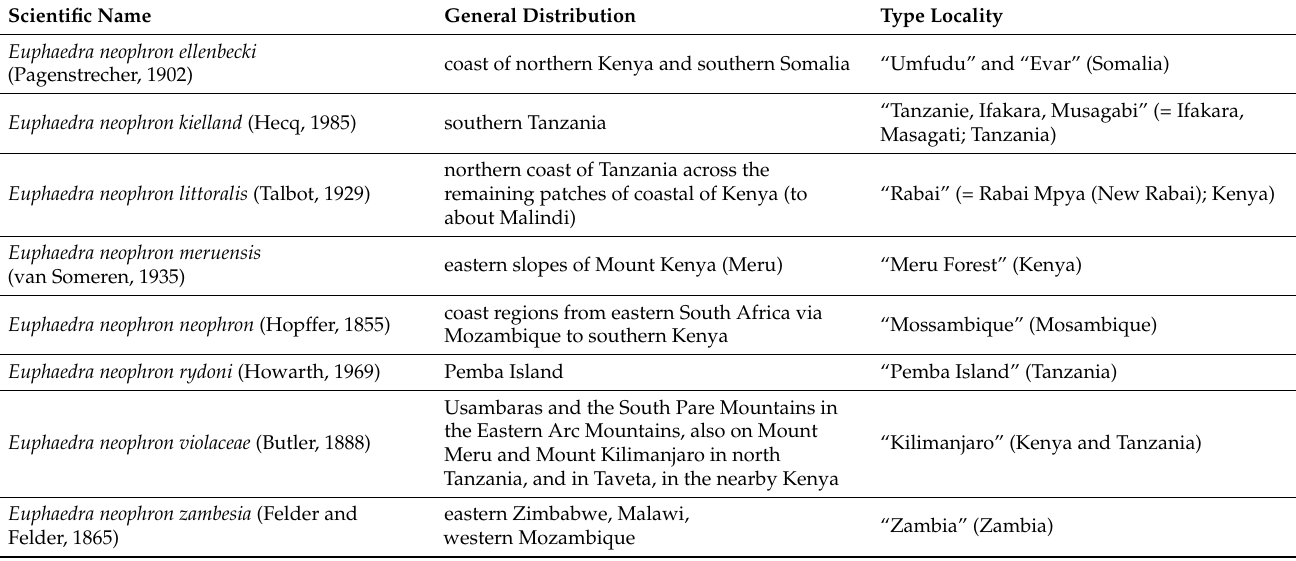
Figure 2. The distribution of hitherto recognised Euphaedra neophron subspecies (squares in various colours) and specimens examined (dark blue spots). State borders are indicated by black, rivers by light blue lines. Table 1. List of Euphaedra neophron subspecies arranged in alphabetical order. General geographical distribution is given. The type locality is indicated between quotation marks (with the actual political state